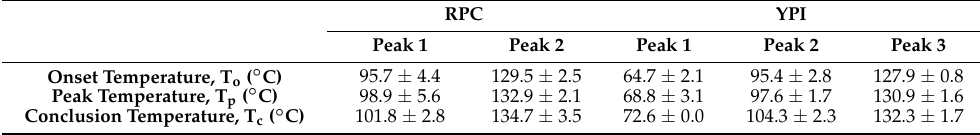
Table 4. Transition temperatures of RPC and